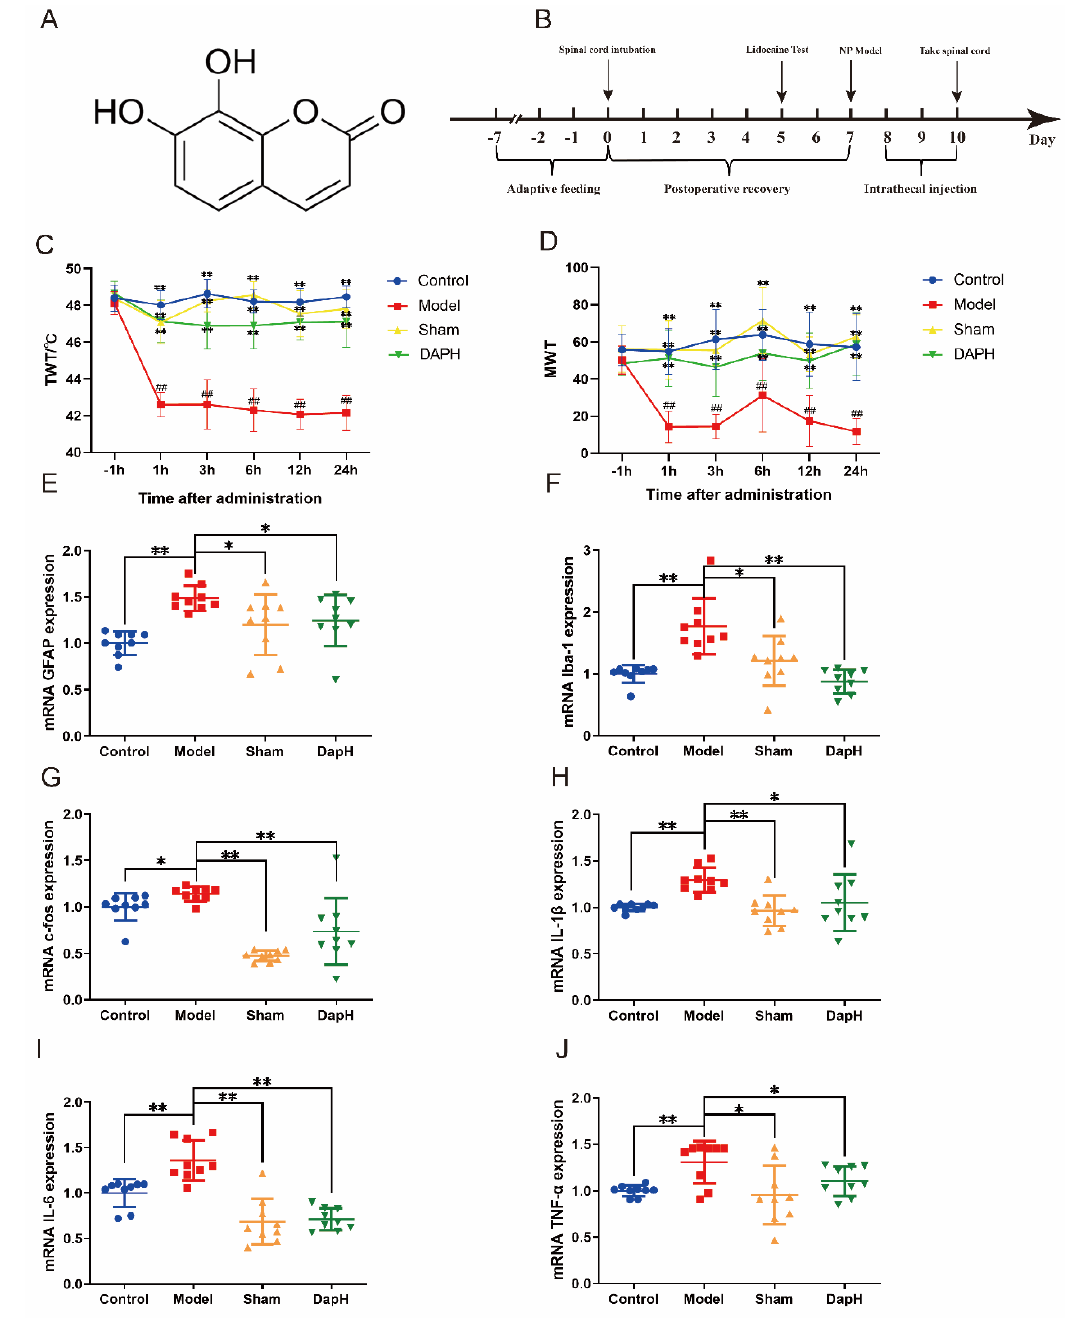
Figure 1. Effect of daphnetin on hyperalgesia in NP rats. ( A ) Structural formula of daphnetin. ( B ) Experimental flowchart. ( C ) Changes in TWT in NP rats ( n = 9). ( D ) Changes in MWT in NP rats ( n = 9). ( E ) mRNA expression of GFAP, a marker of astrocyte activation in the spinal cord ( n = 3). ( F ) mRNA expression of Iba − 1, a marker of microglia activation in the spinal cord ( n = 3). ( G ) mRNA expression of c − fos, a marker of neuronal activation in the spinal cord ( n = 3). ( H − J ) mRNA expression of inflammatory factors in the spinal cord ( n = 3). * p < 0.05, ** p < 0.01 vs. model group (ANOVA); # p < 0.05, ## p < 0.01 vs . before molding (Student’s t -test).